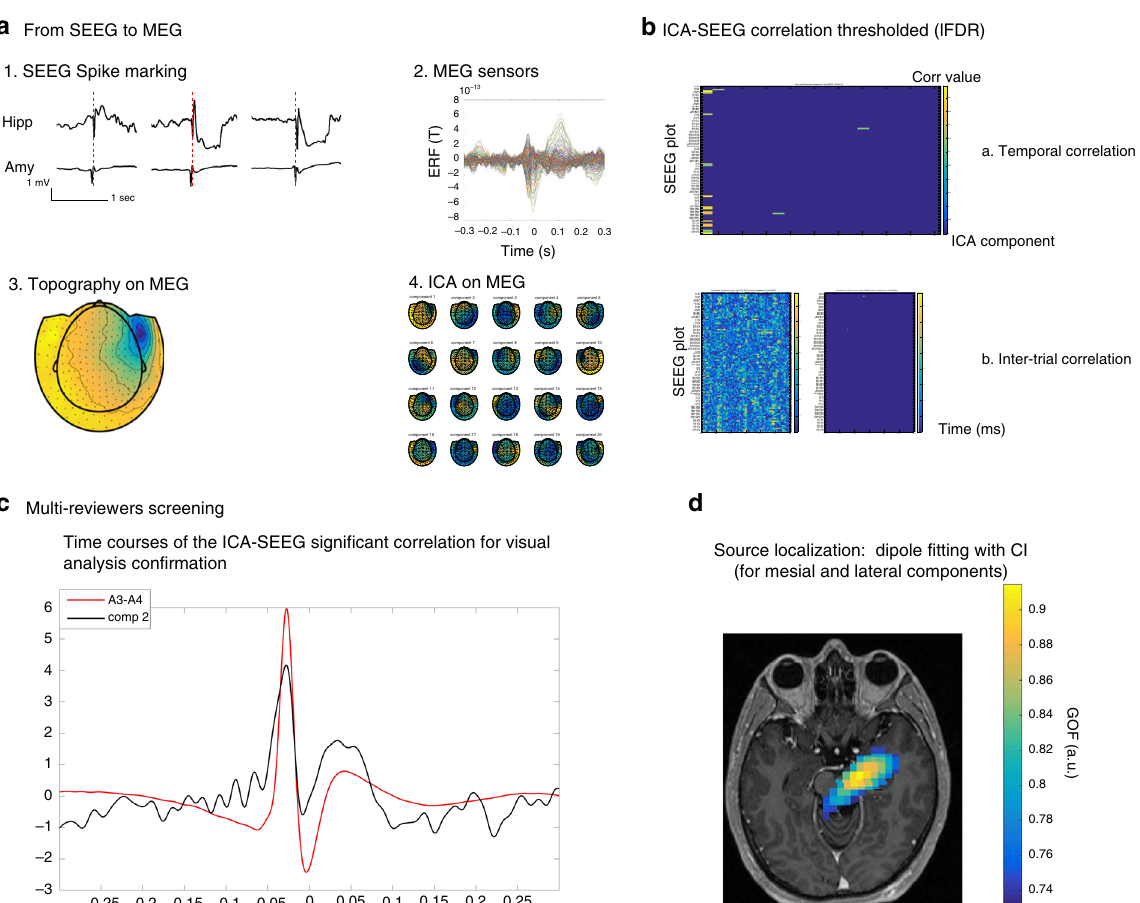
Fig. 5 Methods. Example of SEEG-triggered analysis in P5. a 1. Spike marking on SEEG. Hippocampus and amygdala activity (almost simultaneous): in red marker position based on hippocampus activity 2. MEG sensors time courses at the moment of SEEG markings 3. MEG topography at the moment of SEEG markings 4. ICA topographies (20 components) calculated at the moment of SEEG markings b . a ICA-SEEG temporal correlation thresholded (lFDR):